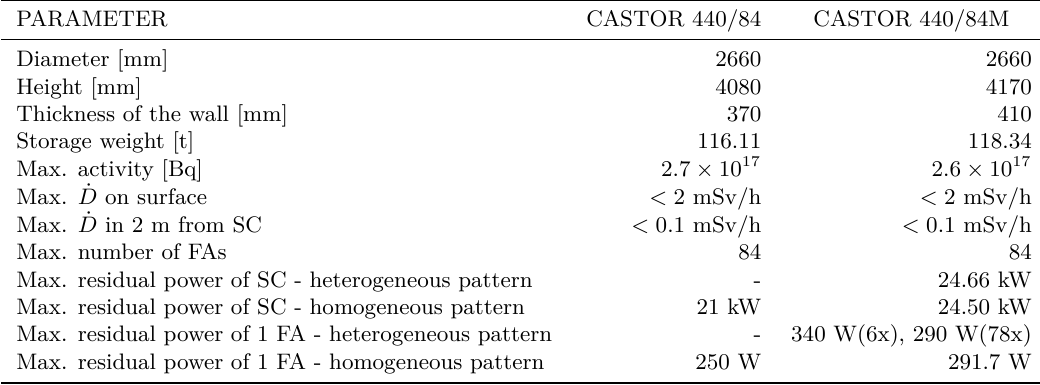
Table 1. Fundamental parameters of the storage and transportation casks CASTOR 440/84 a 440/84M